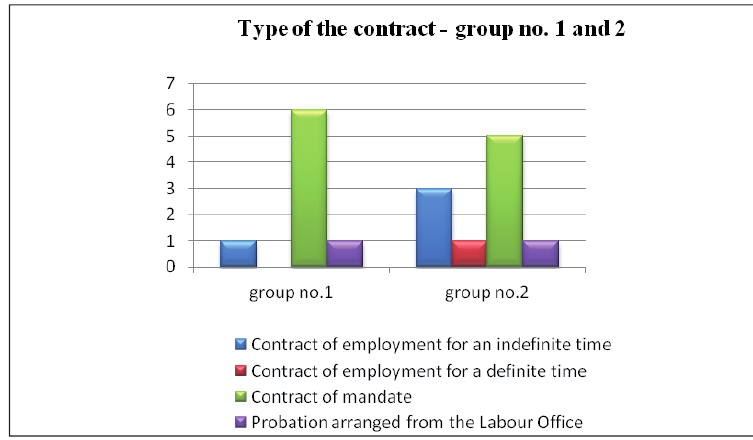
Fig. 3. Contract type of graduates of group 1 and 2